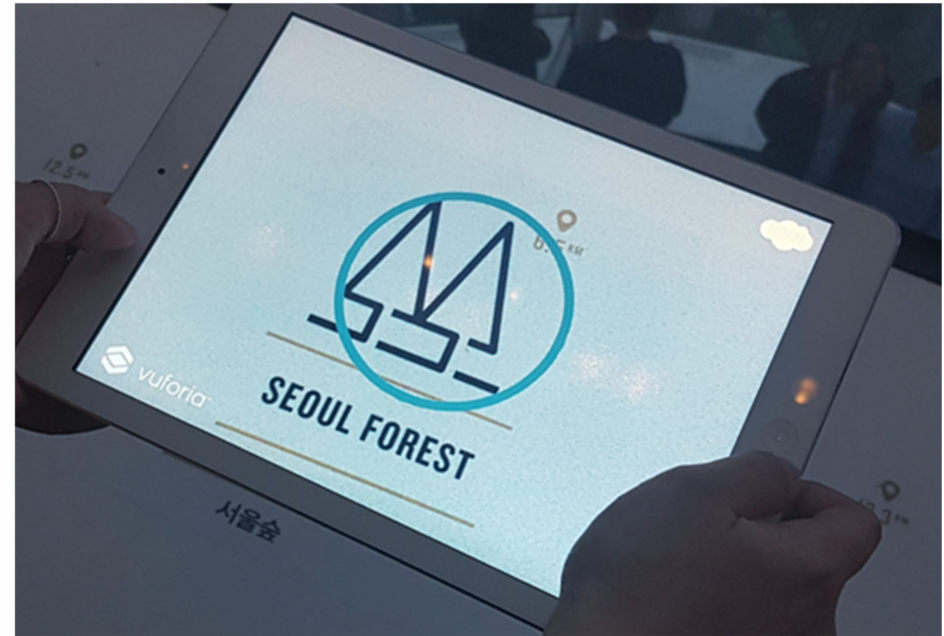
Figure 6. Mission 1 is completed when users find the landmark icon they are looking for in the actual observatory space and register the icon through the